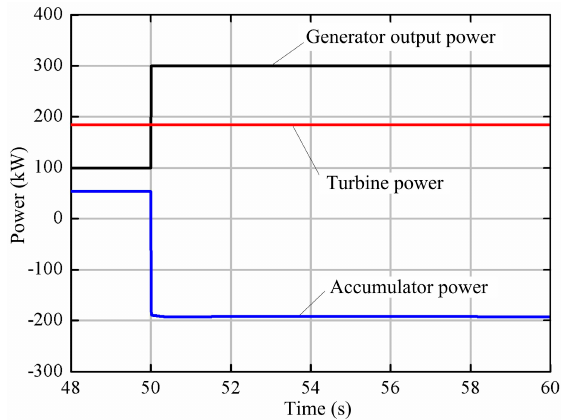
Figure 19. Turbine, accumulator, and generator output power.